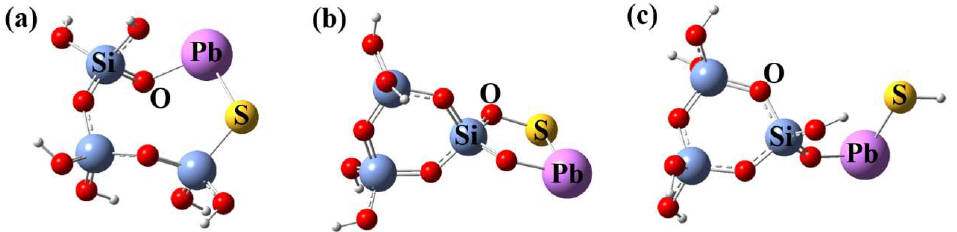
Figure 1. Local structural models of PbS-doped 3MR. ( a ) PbS embedded into the 3MR; ( b ) PbS combined with Si tetrahedron; ( c ) PbS connected with Si tetrahedron by BO. Table 1. Energy parameters of different doping sites in the 3MR microstructural models. Microstructures